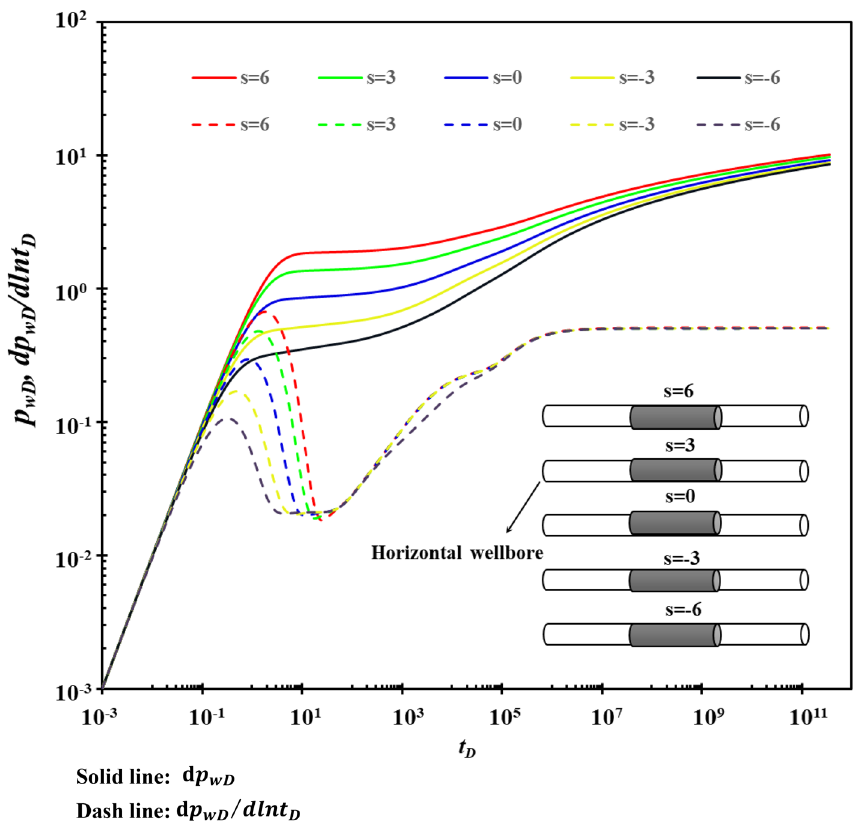
Figure 12. The effect of skin factor on type